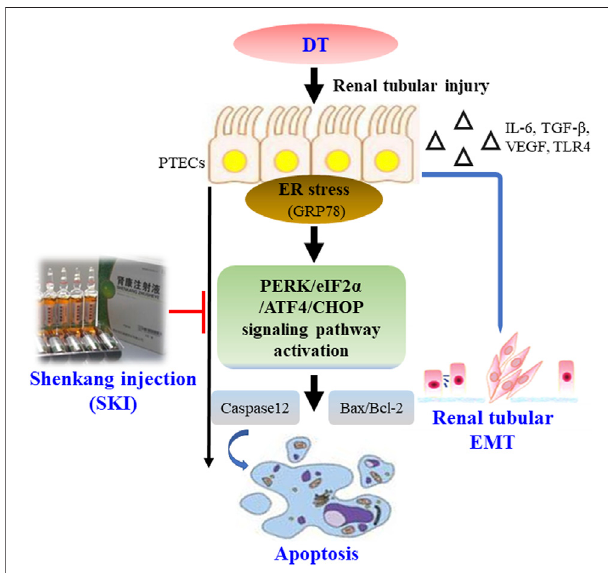
FIGURE14| OverviewoftheeffectofSKIonDTviatheinhibitionofrenal tubular EMT and ER stress-induced apoptosis. Abbreviations: DT, diabetic tubulopathy; EMT, epithelial-to-mesenchymal transition; ER, endoplasmic reticulum; SKI, Shenkang injection.